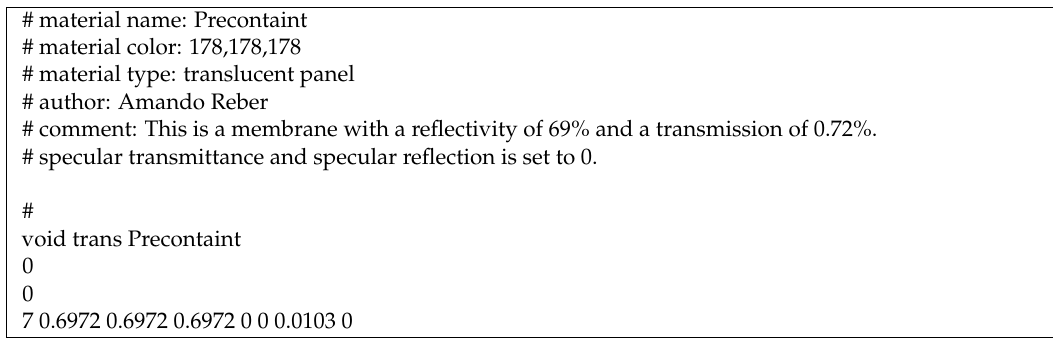
Table A3. Material configuration file of DIVA.